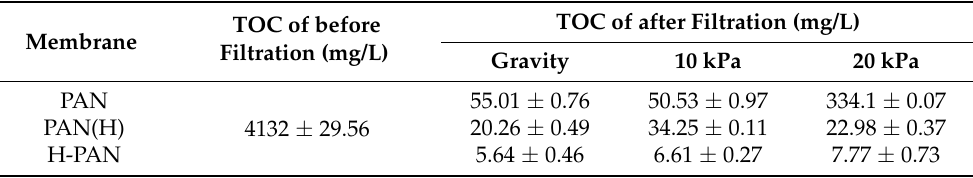
Table 2. The TOC contents of the filtrates from the separation process of soy oil emulsion using different membranes at different driving